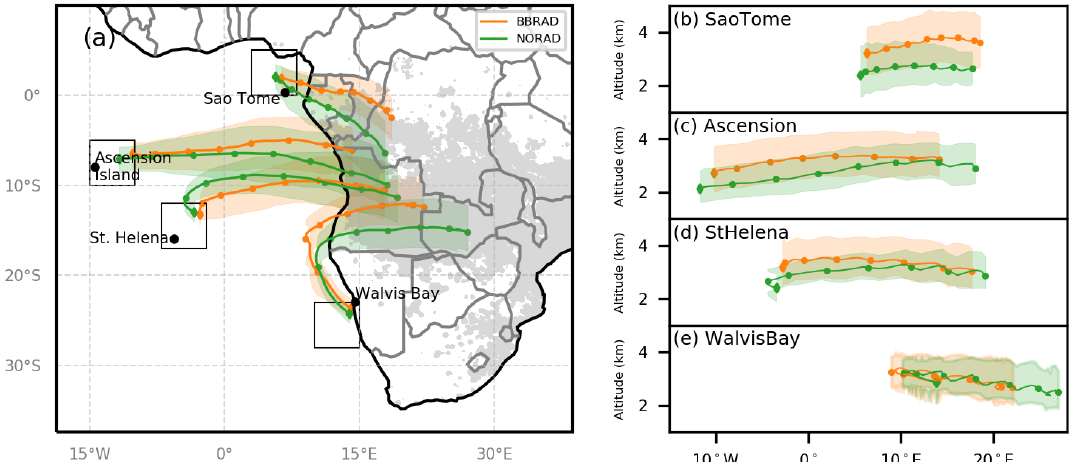
Figure 13. Back trajectories of smoky air parcels ending between 1 and 5km in the São Tomé, Ascension, St. Helena and Walvis Bay areas. The median (bold lines, dots every 24h, diamond at the end of the back trajectory) and the interquartile ranges (shading) are shown for the BBRAD (orange) and NORAD (green) ensembles. In panel (a) , fire sources are shaded in grey and interquartile ranges are for latitude. In panels (b) – (e) , the interquartile ranges are those of altitude. Results are averaged from 7d trajectories ending at 12:00UTC every day between 8 and 16 September